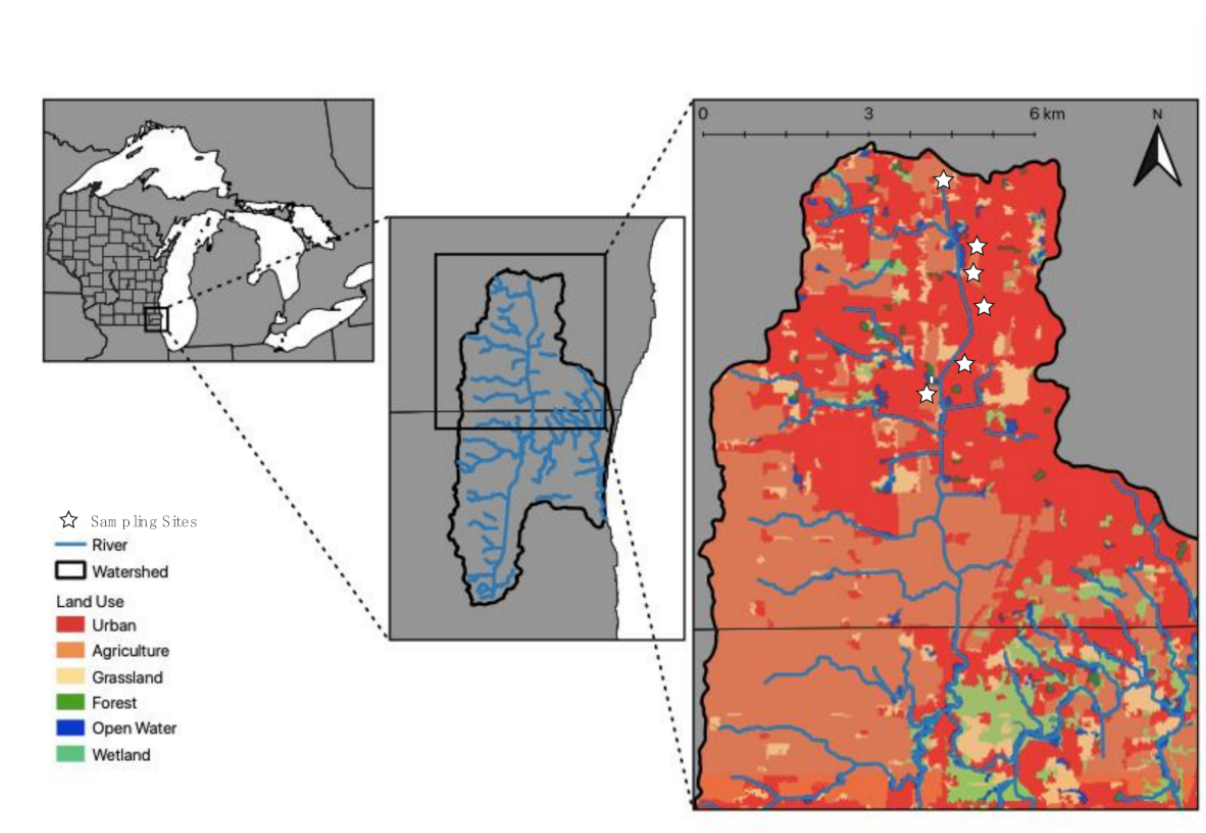
Figure 1. Map of the Pike River North Branch (42 ◦ 43 (cid:48) N and 87 ◦ 52 (cid:48) W) displaying surrounding land use (adapted from Southeastern Wisconsin Regional Planning Commission, SEWRPC 2010). Wetland sampling sites are indicated by white stars and were numbered sequentially from 1 to 6 from north to